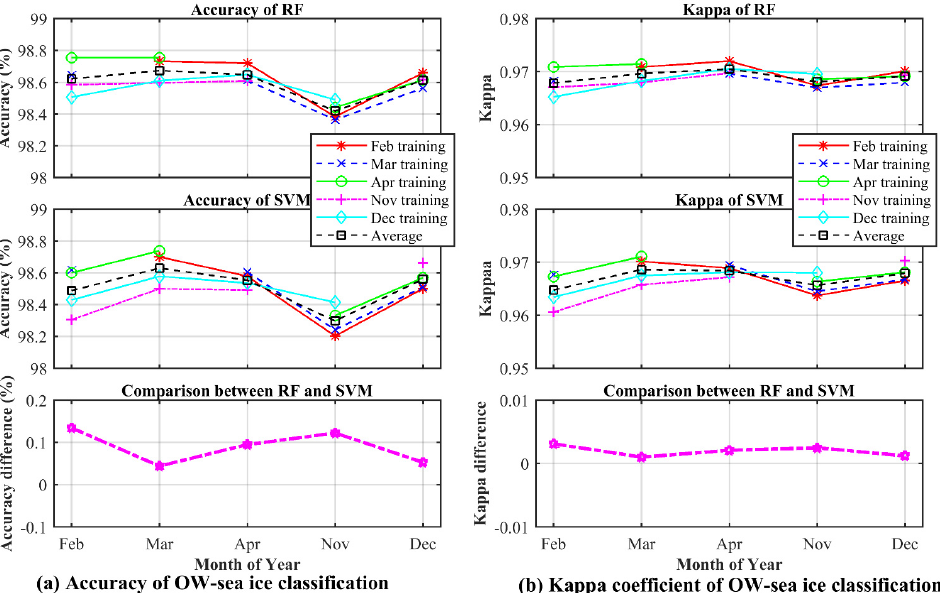
Figure 14. The ( a ) accuracy and ( b ) kappa coefficient of OW-sea ice classification using data of each month as the training set in turn. The top and middle plots in ( a ) represent the accuracy of RF and SVM respectively, while the lowest plot is the accuracy of RF minus that of SVM. The top and middle plots in ( b ) represent the kappa coefficient of RF and SVM respectively, while the lowest plot is the kappa coefficient of RF minus that of SVM.